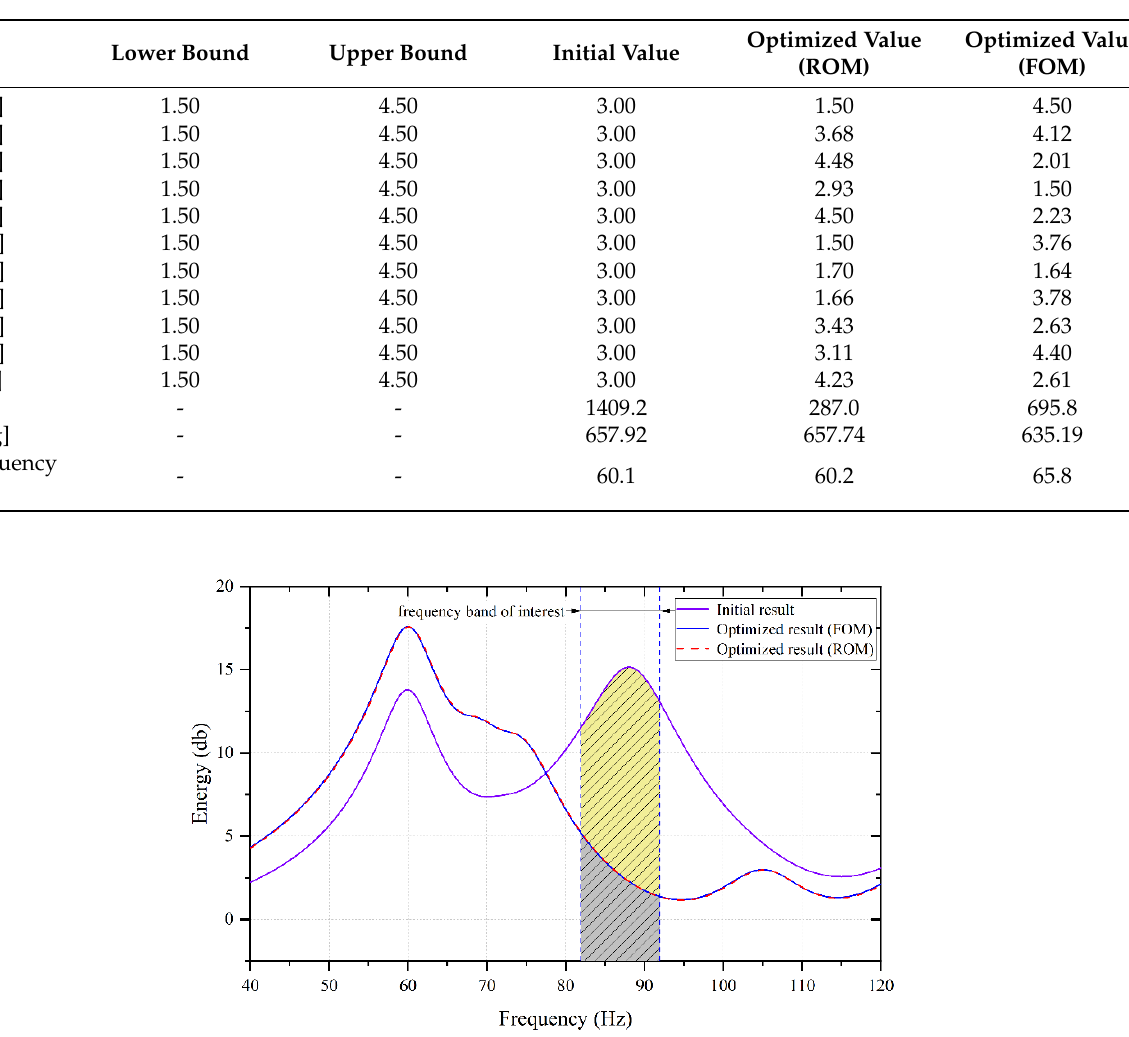
Table 2. Vibration reduction optimization results of the S-shaped curved stiffened shell.